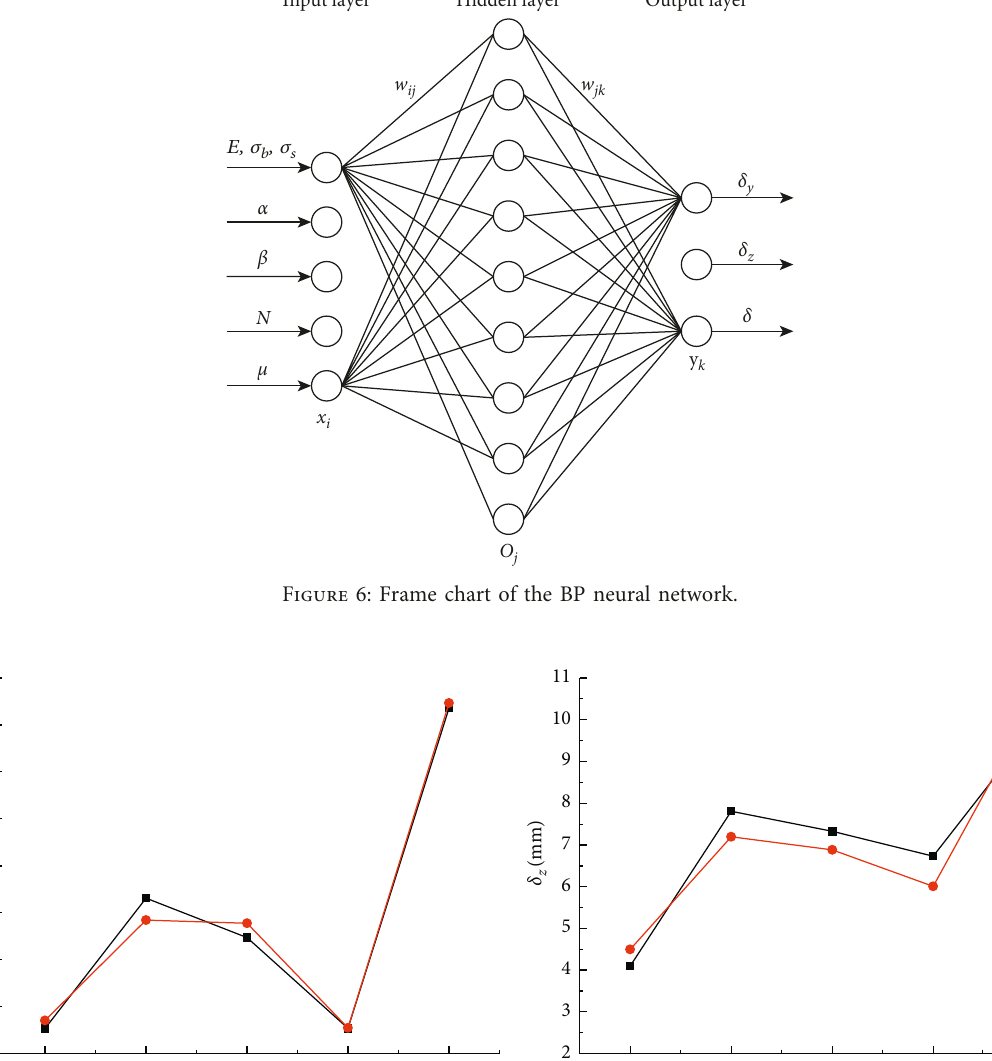
1 B 1 C 1 D 4 E 3 ).